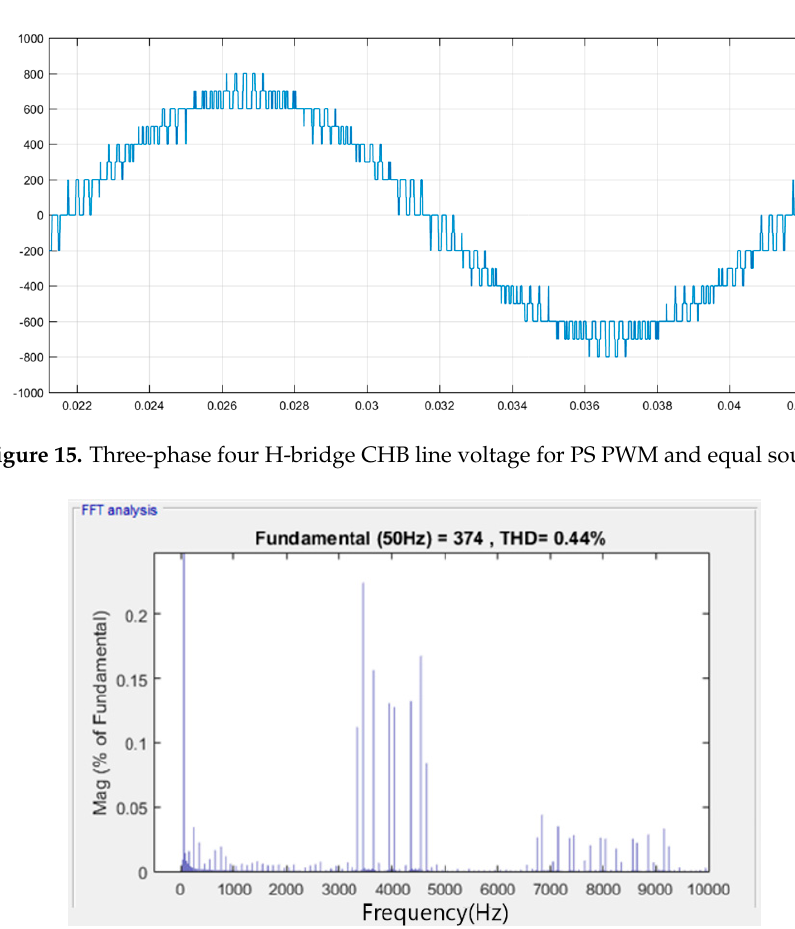
Figure 16. Three-phase four H-bridge CHB current THD for PS PWM and equal sources.